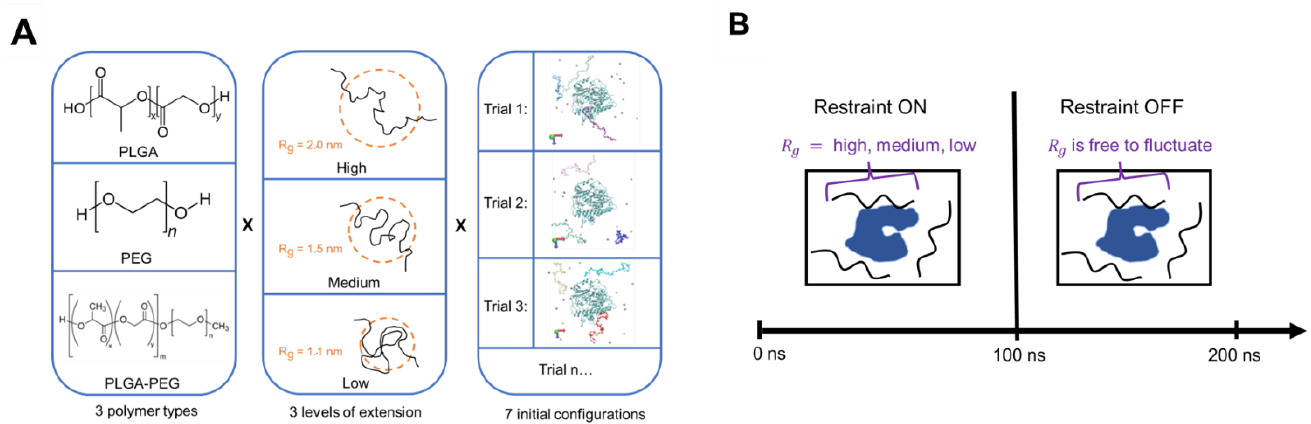
Table 1. The monomer length (N mon ) and contour length (L c ) of the 3 oligomers, for each polymer type, simulated in this study. Each PLGA-PEG oligomer consisted of N LGA = 12 and N EG = 13. This was performed to ensure that the simulated oligomers were still diblock copolymers with a nearly 1:1 LGA:EG ratio at the given contour length.